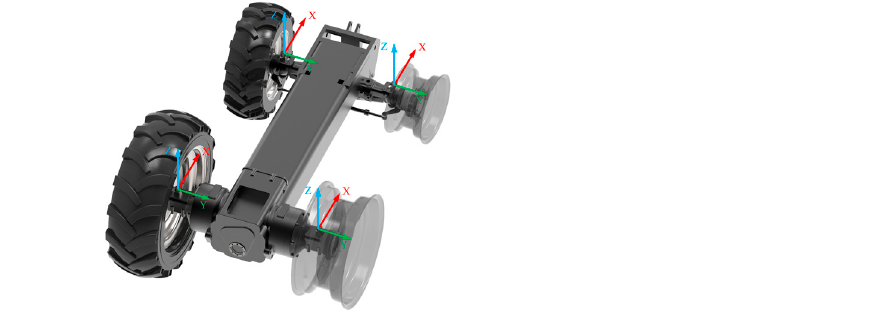
Table 3. Speed of different ground experiments. Ground Selection